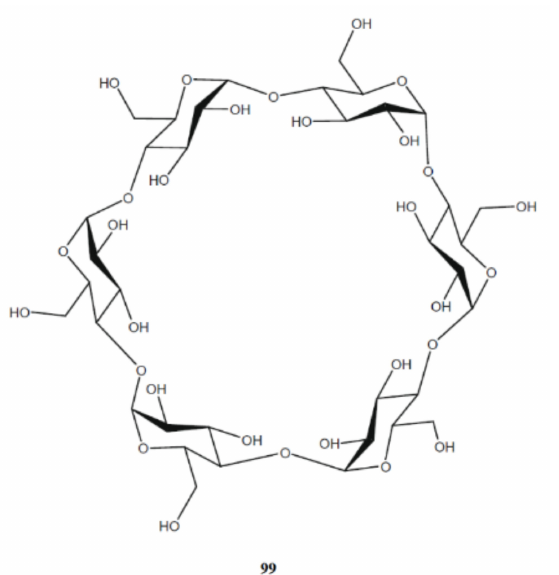
Scheme 10. The structure of α -cyclodextrin (six subunits). Reproduced from Tafazzoli and Ghi- asi [164] with the permission of Elsevier.